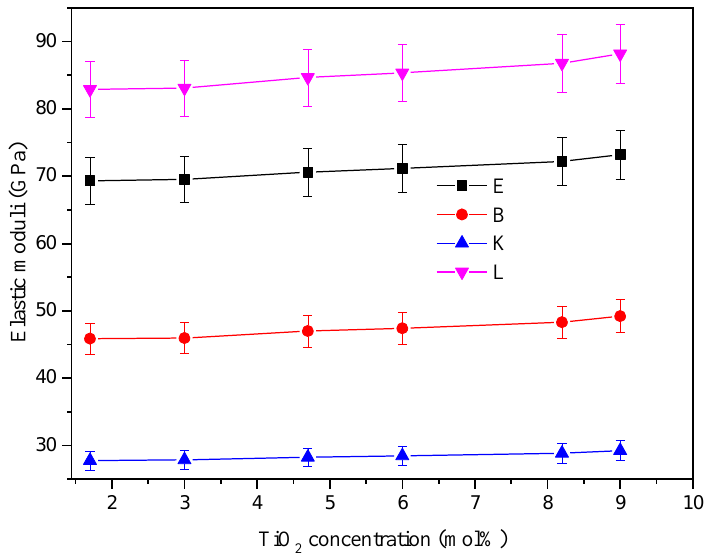
Figure 4. Variation of elastic moduli like the Young (E), bulk (B), shear (K), and longitudinal (L) properties as a function of TiO 2 concentration.